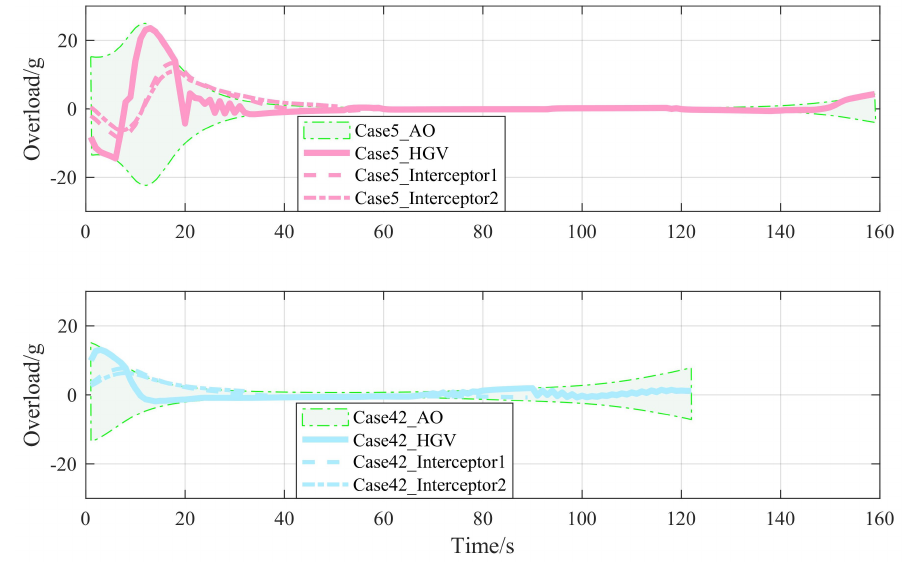
Figure 12. Overloads comparison between Cases 5 and 42.